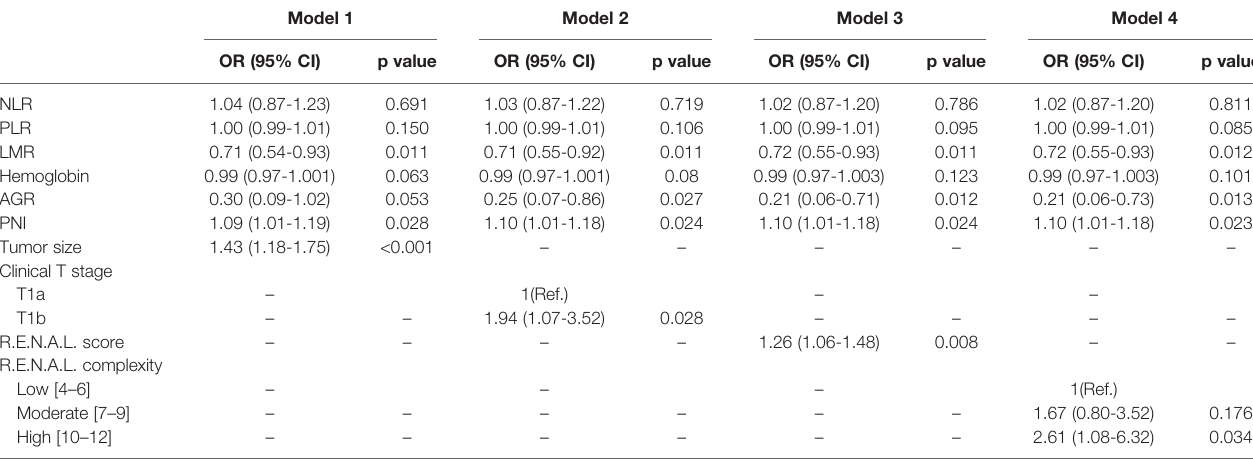
TABLE 5 | Multivariable logistic regression analyses predicting pathologic T3a upstaging in patients diagnosed with clinical T1 renal masses undergoing nephrectomy.